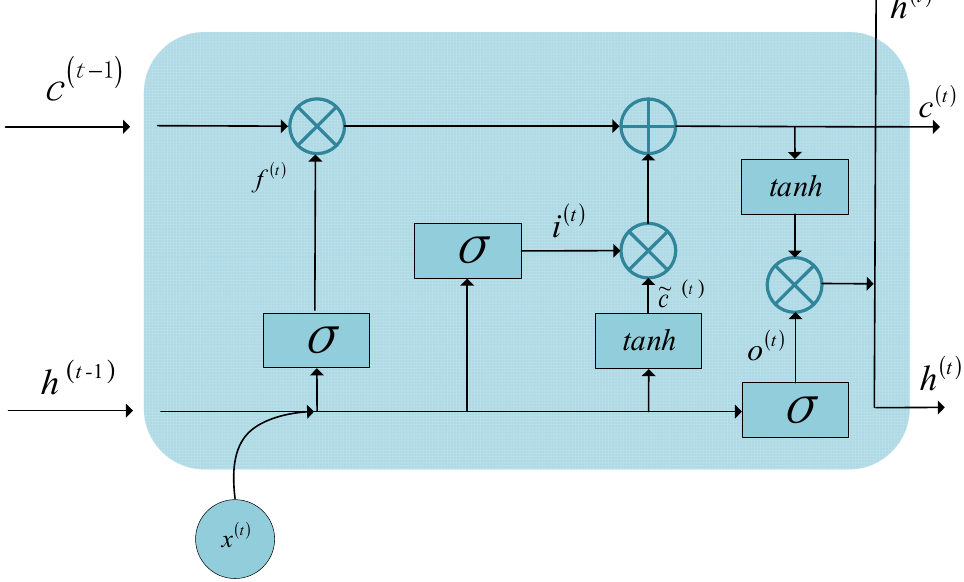
Figure 2. LSTM architecture.